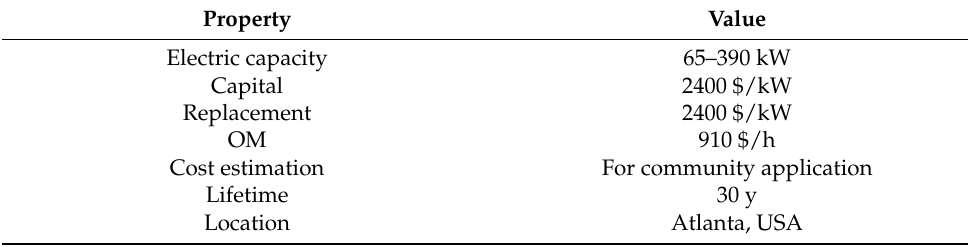
Table A12. PV parameters [42,43].